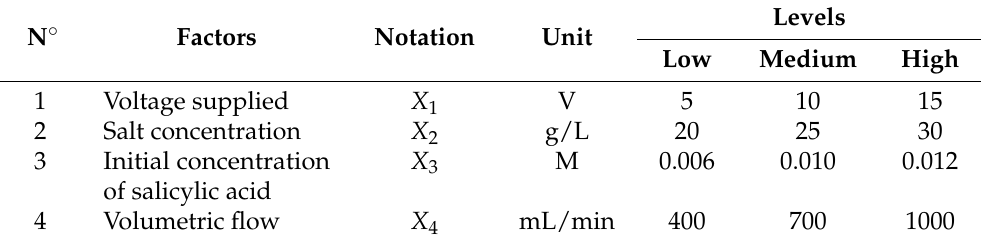
Table 2. Parameters and their values corresponding to their levels studie in